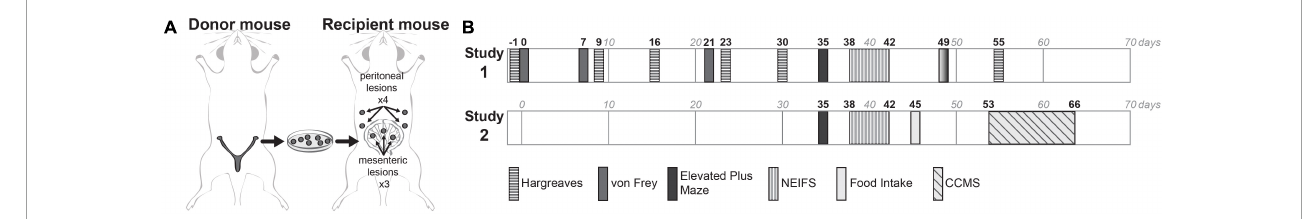
FIGURE1 Experimental plan. (A) For the induction of endometriosis in mice, the syngeneic transplantation model was performed surgically implanting seven biopsies into recipient mice: three biopsies from donor mouse were attached on the mesentery of the small intestine and four on the abdominal wall of the interior of the abdomen. (B) Two independent studies were executed, with evaluation of different endpoints. In the first study (study 1) mechanical and thermal pain-related behaviors were assessed with the von Frey test and Hargreaves test at different timepoints, and anxiety-related behaviors were performed by the EPM and NEIFS assays at days 35 and 38–42 after surgery. In the second study only anxiety-related behaviors were measured at the same timepoints. Additionally, monitoring of locomotive activity by the CCMS assay was performed at days 53–66 after surgery.